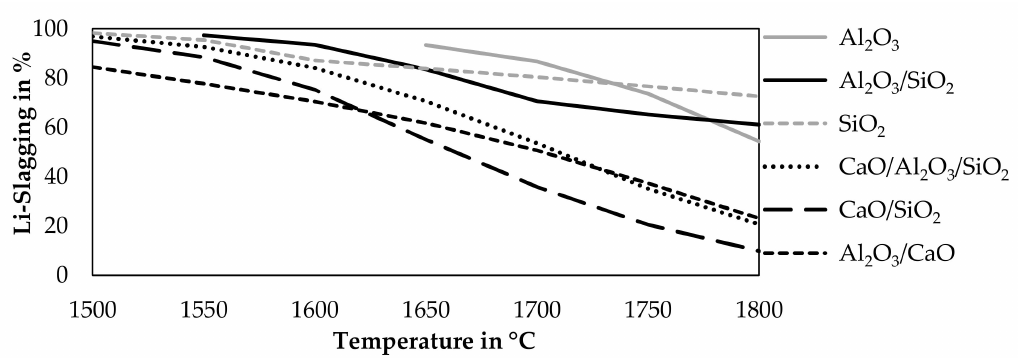
Figure 4. Influence of temperature on the Li-slagging using 21 g of fluxes and 65 g of CuO per 100 g black mass.